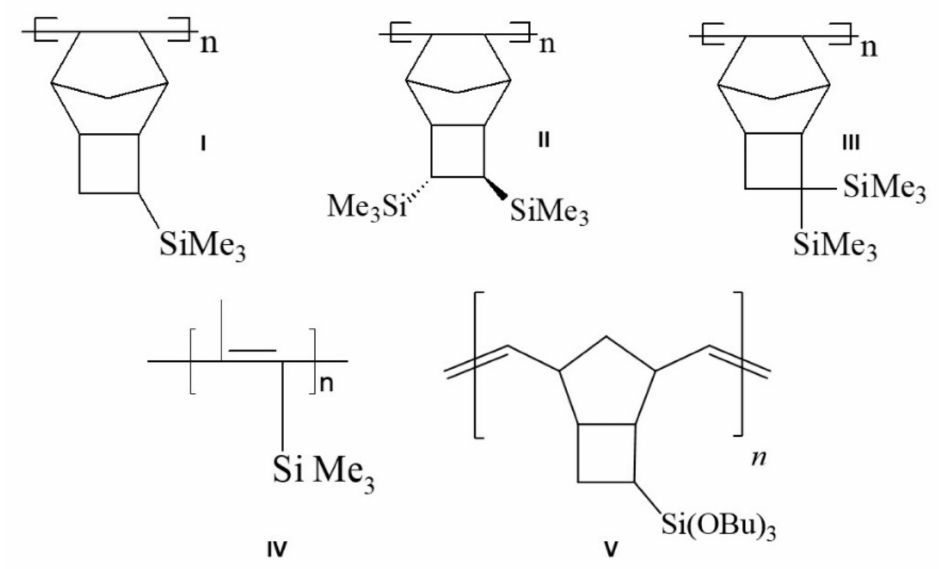
Figure 2. Structures of the investigated polymers: I—addition poly(3-trimethylsilyltricyclononene-7), II—addition poly(3,4-bis(trimethylsilyl)tricyclononene-7), III—addition poly(3,3-bis(trimethylsilyl) tricyclononene-7), IV—poly(trimethylsilylpropine), V—metathesis